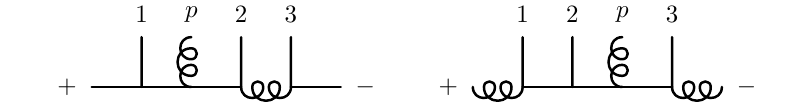
Figure 8 . The half integrand in (4.18) receives contributions from forward limits in both scalars (left panel) and gluons (right